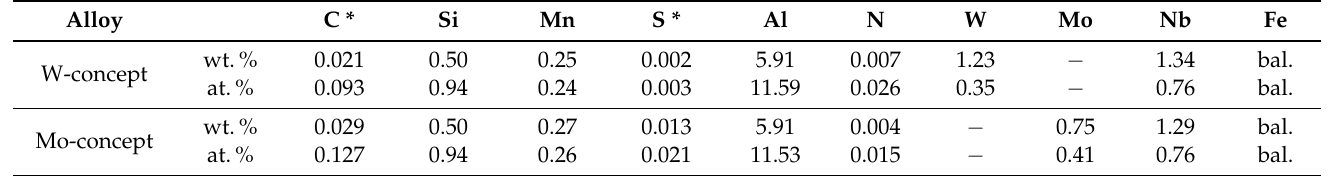
Table 1. The selection of the alloying concepts was based on T HERMO C ALC simulations using TCFE9 database. Table 1. Chemical composition of the two steels analyzed with spark spectral